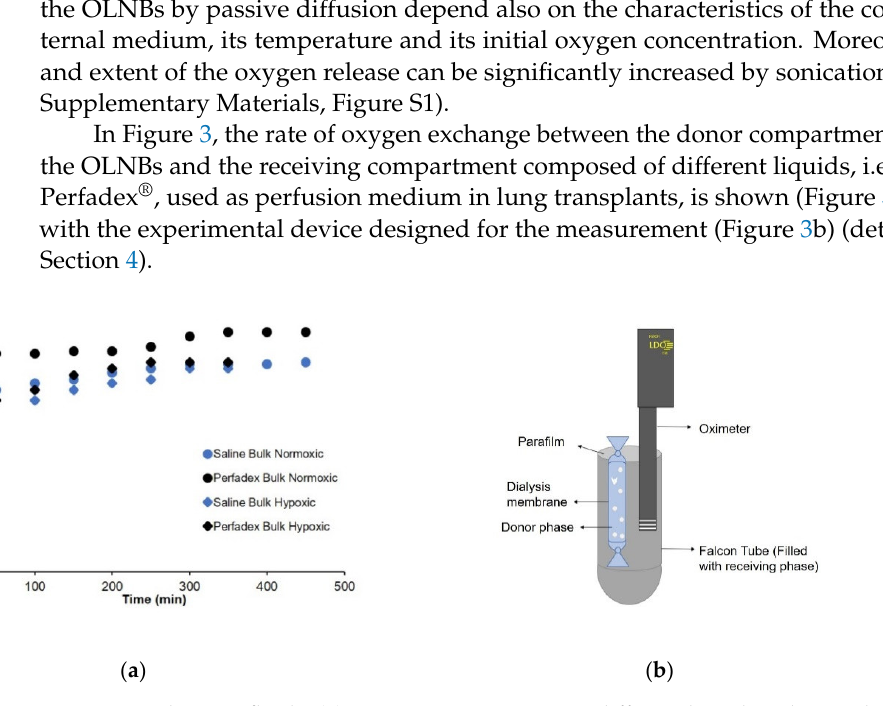
Figure 2. TEM ( a ), optical fluorescence ( b ) and US ( c ) imaging of OLNBs.